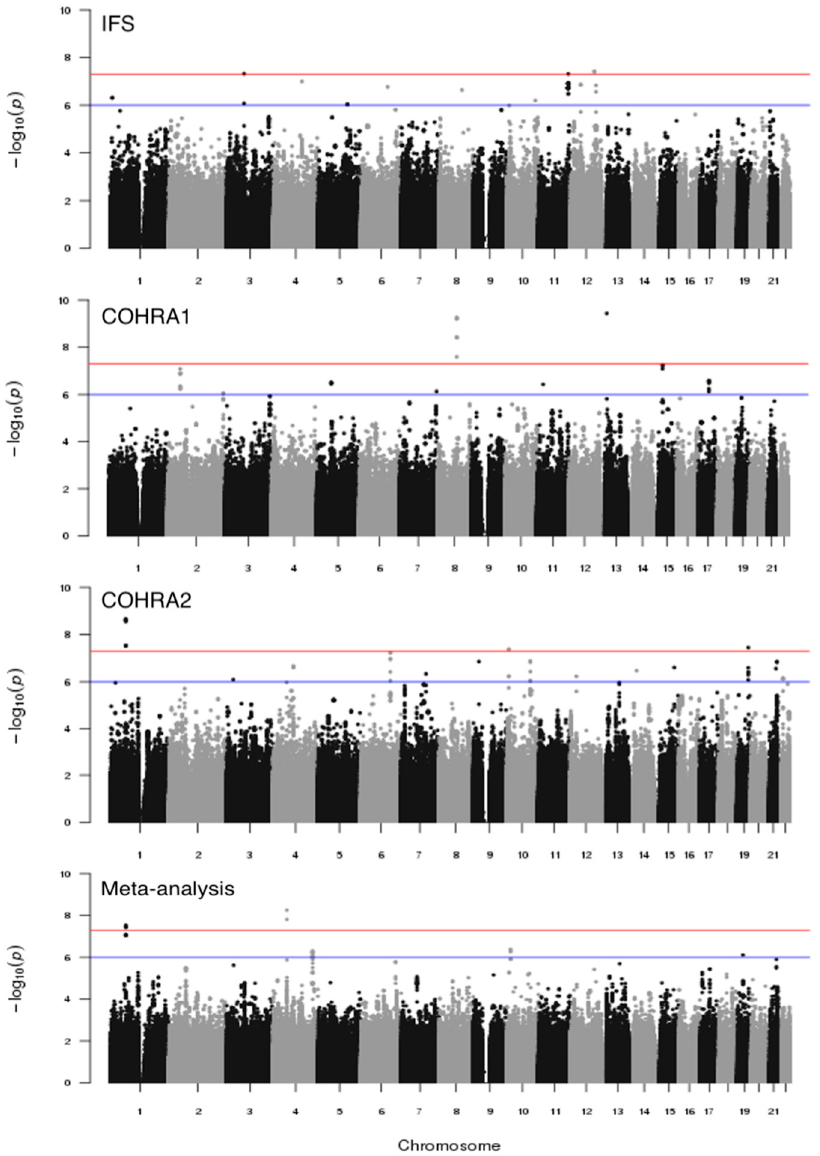
Figure 2. Manhattan plot for genome-wide vQTL scans of dfs in IFS, COHRA1, COHRA2, and meta-analysis; − log 10 -transformed p -values (y-axis) for each SNP organized by physical position across the chromosomes (x-axis) are shown. Horizontal lines represent the genome-wide significant (5 × 10 -8 ) and suggestive (1 × 10 -6 ) p -value thresholds. Table 2. 40 prioritized SNPs ( p < 1 × 10 -6 ) from vQTL of dfs in IFS, COHRA1, COHRA2, and meta- analysis.